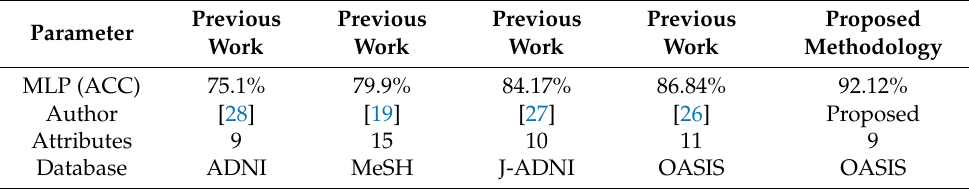
Table 5. Comparison of ML with State of the Art .